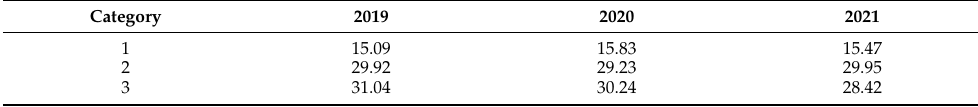
Table 6. Number of suicides per 100,000—men